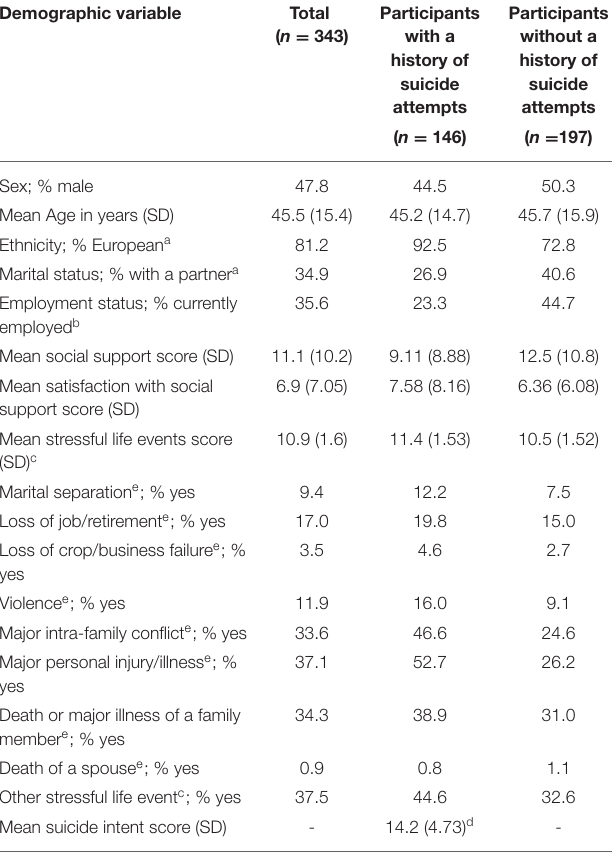
TABLE 1 | Demographic characteristics of participants with and without a history of suicide attempts. Demographic variable Total